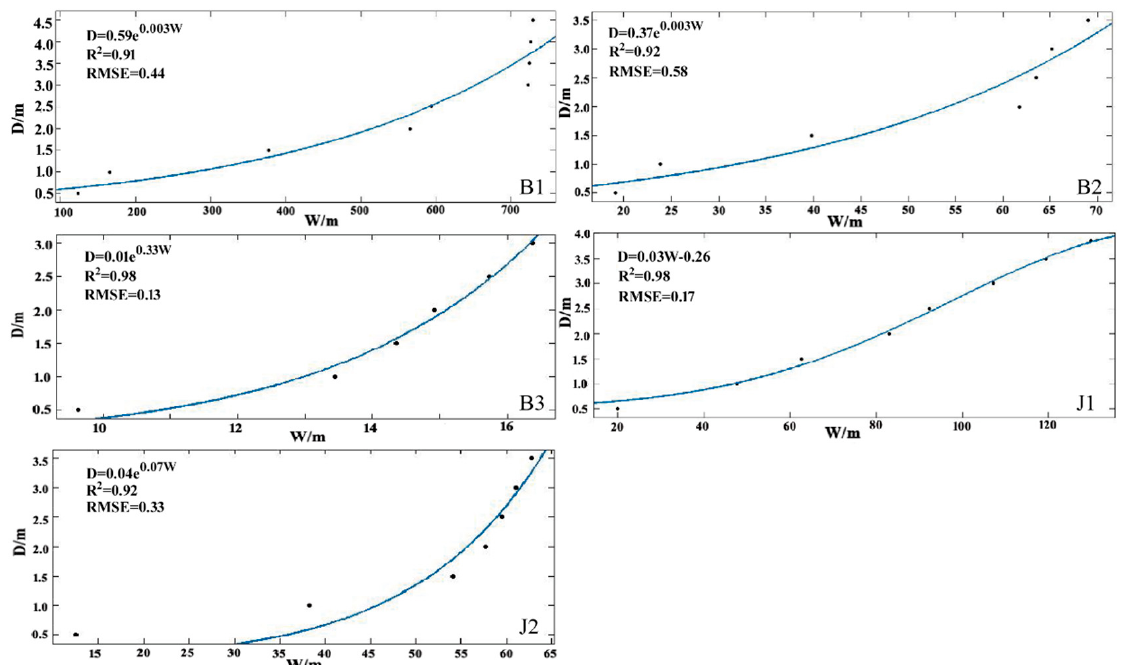
Figure 4. Fitting relationship between average water surface width and water depth of river sections at different monitoring stations. B1~B3 are the width-depth fitting curves of Bortala River section; J1~J2 are the width-depth fitting curves of Jinghe River section.